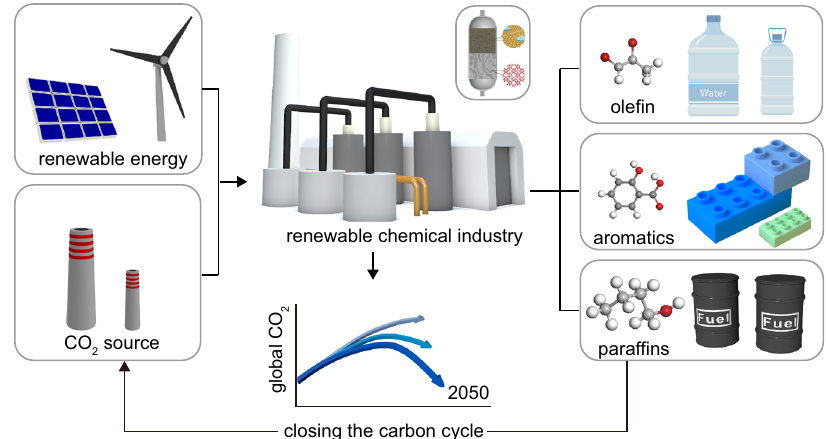
Fig. 1 The big picture. Exploring the mitigating potential of carbon capture and utilization (CCU) on climate change, through decoupling chemical production from fossil resources. The potential success of this CCU-based approach heavily relies upon the amount of CO 2 stored in the fi nal products. Herein this work, through the production of carbon-rich high volumetric energy density (C 2 + ) chemicals (ole fi ns, aromatics, and paraf fi ns) from CO 2 , our CCU strategy would allow us to “ bend the curve ” of global CO 2 emission from “ cradle to gate ” in the chemical industry, and thus, to take the right step toward a closed-loop anthropogenic carbon